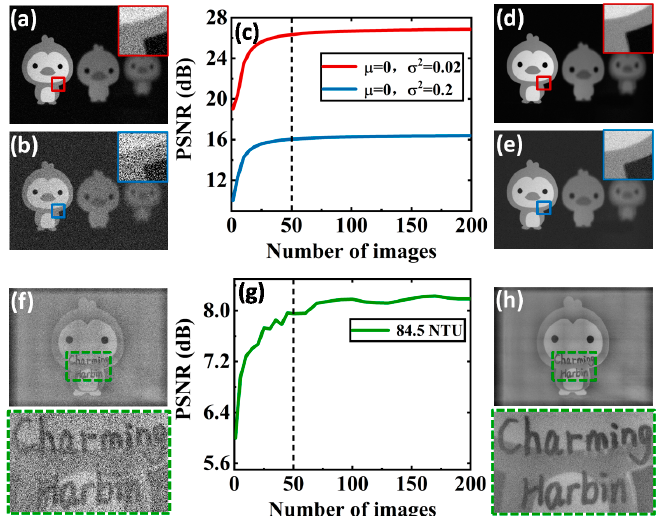
Figure 7. ( a ) and ( b ) are the results of artificially adding different random noises to the target image captured in clear water; ( c ) PSNR curves of the average results of different numbers of multiple frames in two cases; ( d ) and ( e ) are the multi-frame averaged results when N = 50 in two cases; ( f ) S pro is obtained by processing the images captured in 84.5NTU turbid water; ( g ) PSNR curve after 1 multi-frame averaging of different numbers of S pro ; ( h ) the results of S pro after multi-frame averaging i i when N =